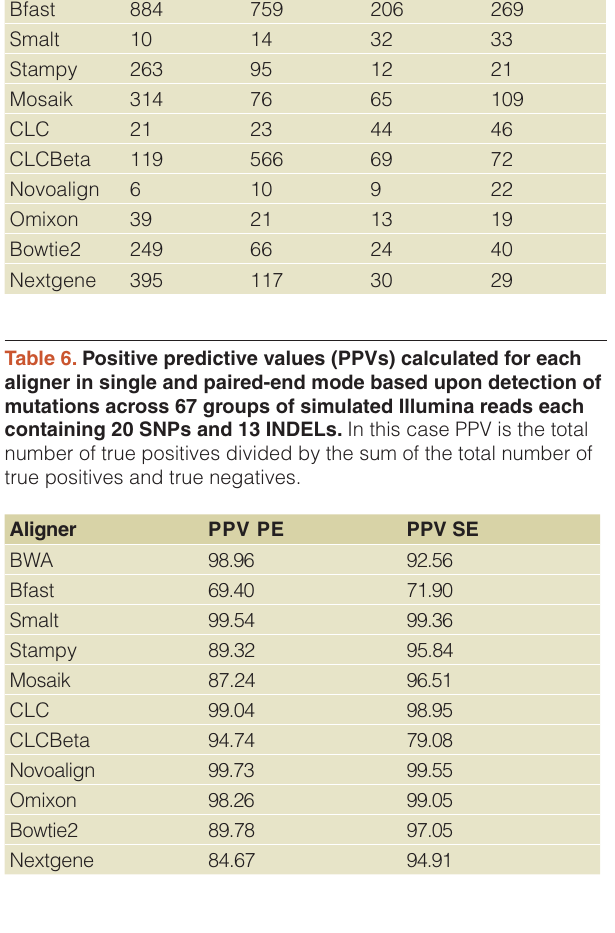
of INDELs in some instances. For example BWA saw a marked